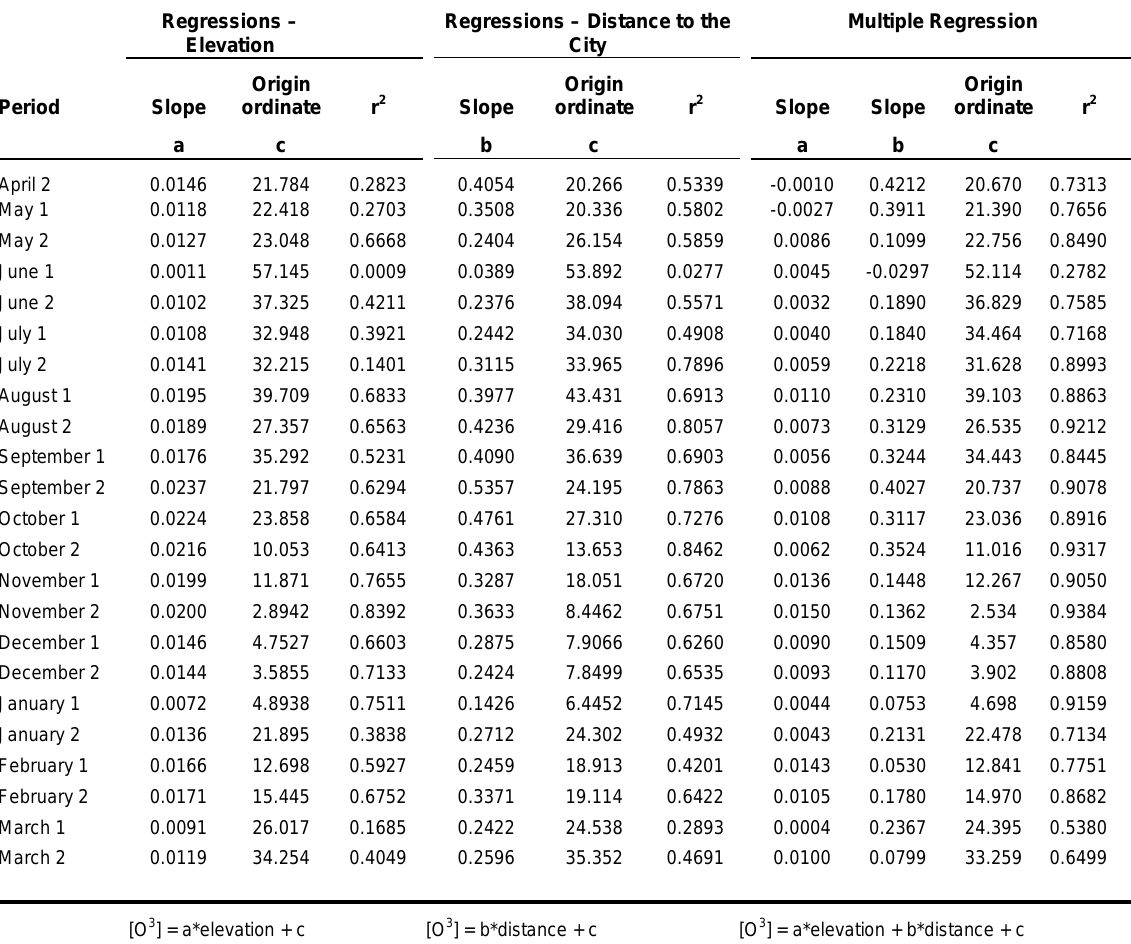
Slope, Origin Ordinate, and Regression Coefficient ( r 2 ) between Ozone 2-Week Average Distance and Elevation* Regressions – Regressions – Distance to the Multiple Elevation City